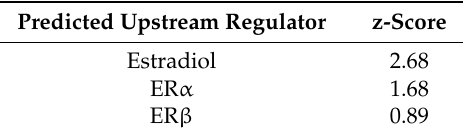
Table 1. IPA of blackcurrant extract (BCE)-treated normal human female skin fibroblast cell line (TIG113) cells.